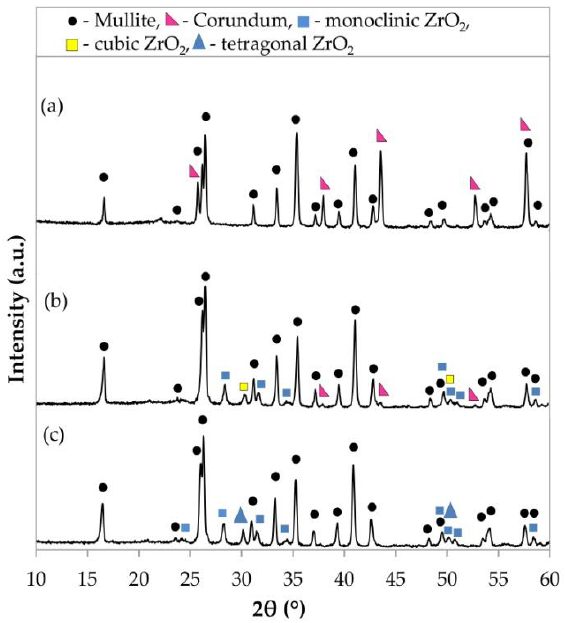
Figure 1. X-ray diffraction data of the sintered porous ceramic materials: ( a ) undoped samples, ( b ) samples with YSZ and ( c ) samples with MSZ.